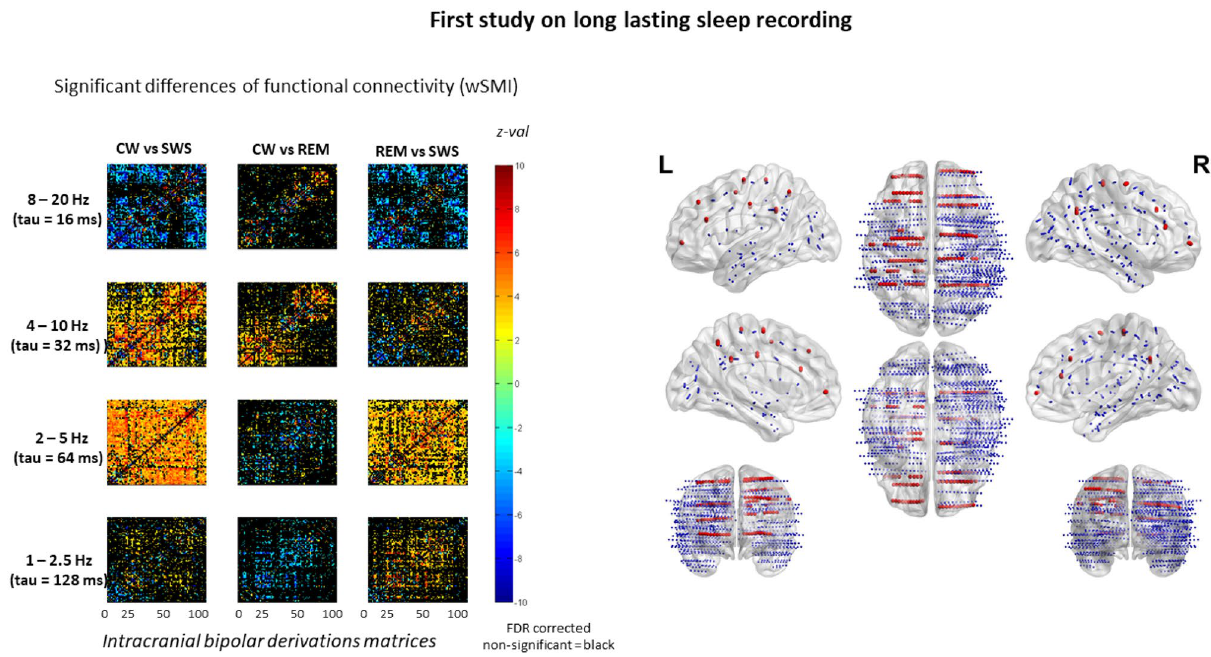
Figure 1. Matrices (bipolar derivations × bipolar derivations) of statistical comparison of the mean wSMI values between stages in patient 1. Color bar corresponds to the z-values. Non-significant results are plotted in black. Tridimensional representation of the electrodes in the MNI space. Electrode of patient 1 are plotted in red. CW conscious wakefulness, SWS N3 slow wave sleep, REM rapid eye movement sleep, wSMI weighted symbolic mutual